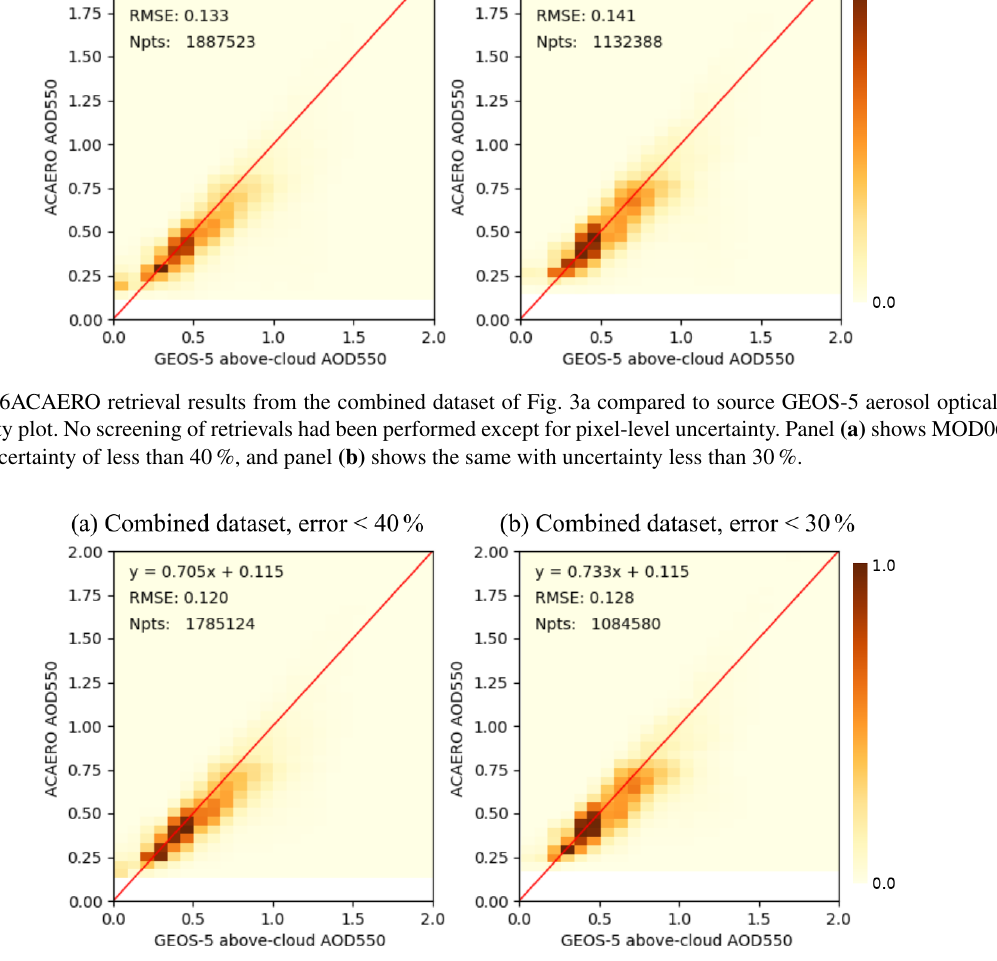
Figure 5. MOD06ACAERO retrieval results from the combined dataset of Fig. 3a compared to source GEOS-5 aerosol optical depth as a normalized density plot. AOD retrievals where COT was less than 4 are now discarded. Panel (a) shows MOD06ACAERO retrievals with uncertainty of less than 40%, and panel (b) shows the same with uncertainty less than